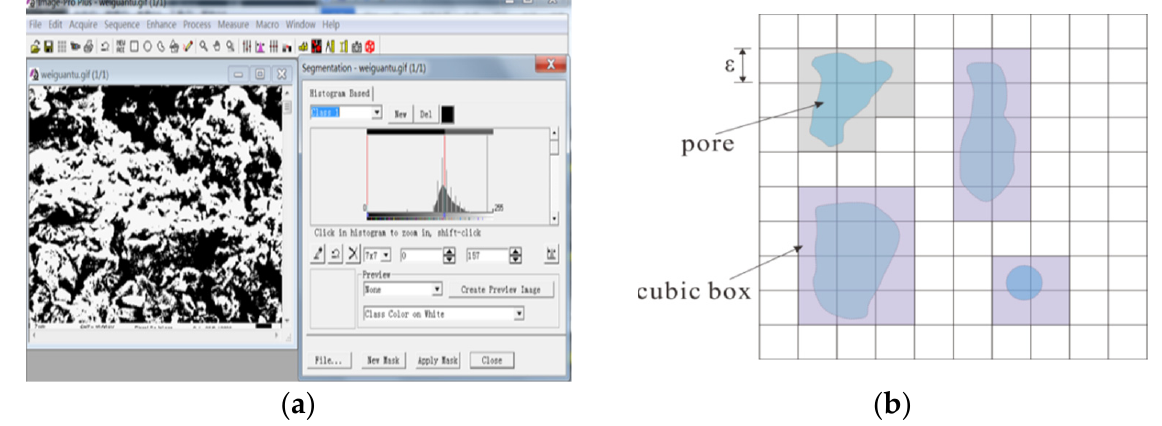
Figure 5. ( a ) IPP 6.0 software analysis, ( b ) Box-counting dimension diagram.